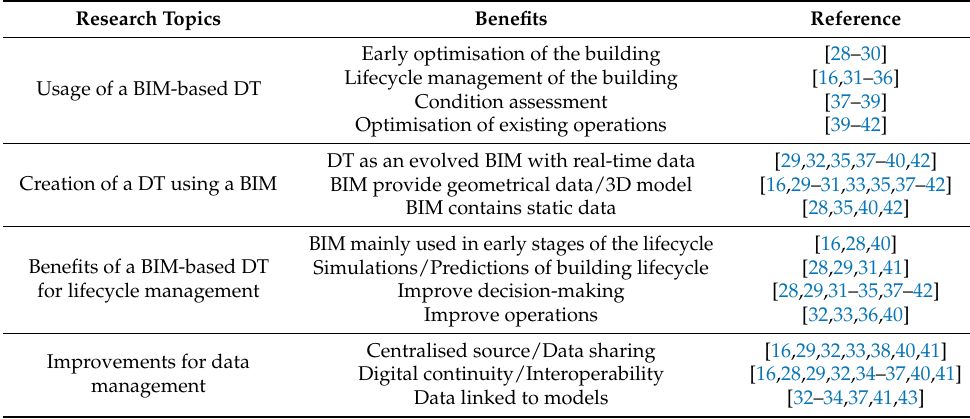
Table 2. BIM as a basis for creating a DT for the construction